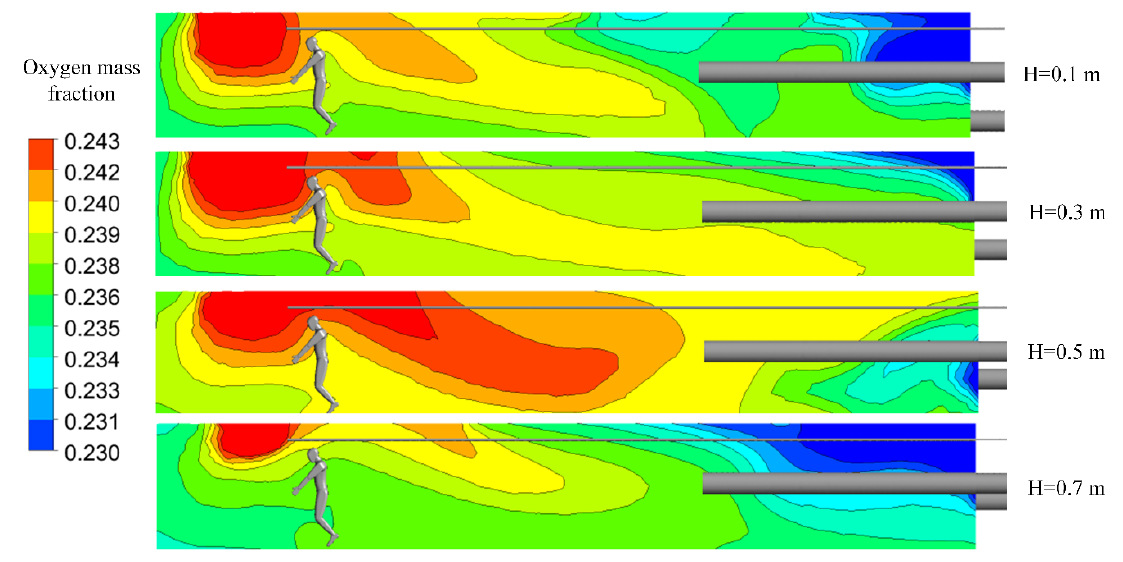
Figure 11. Distributions of oxygen mass fractions at section X = 0 m.